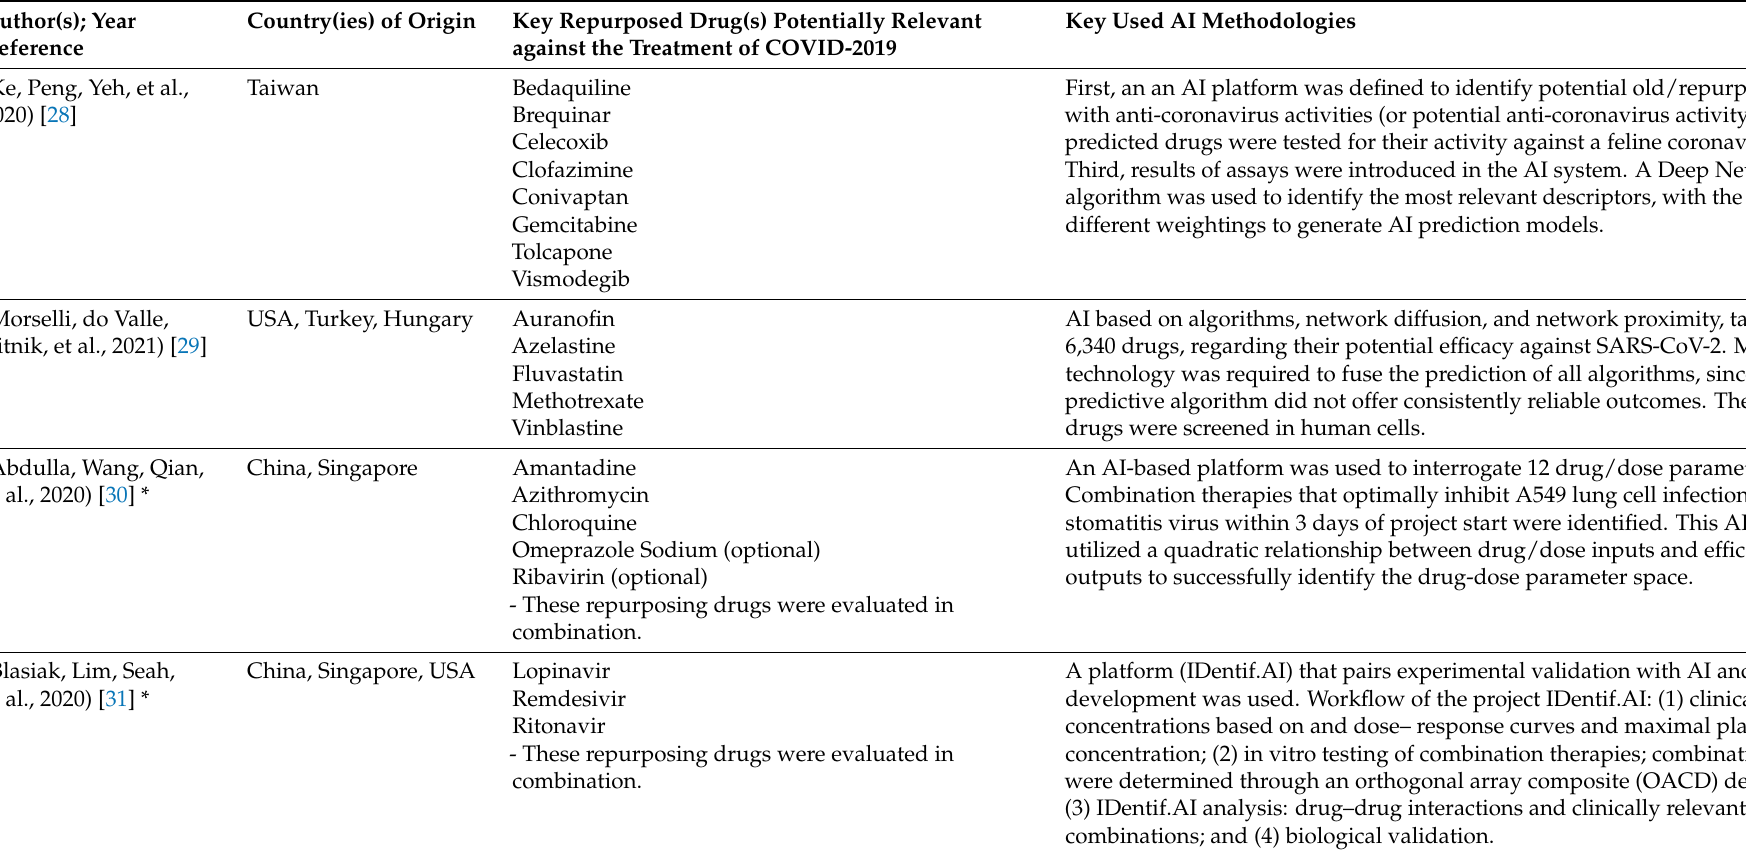
Table 1. Some relevant aspects of the 17 selected